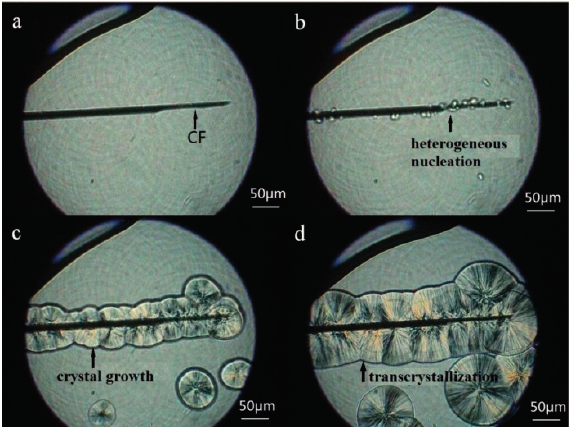
Figure 3. Optical microscopic images (500×) of PP/GNs composites at ( a ) 200 °C and ( b – d ) near 130 °C.